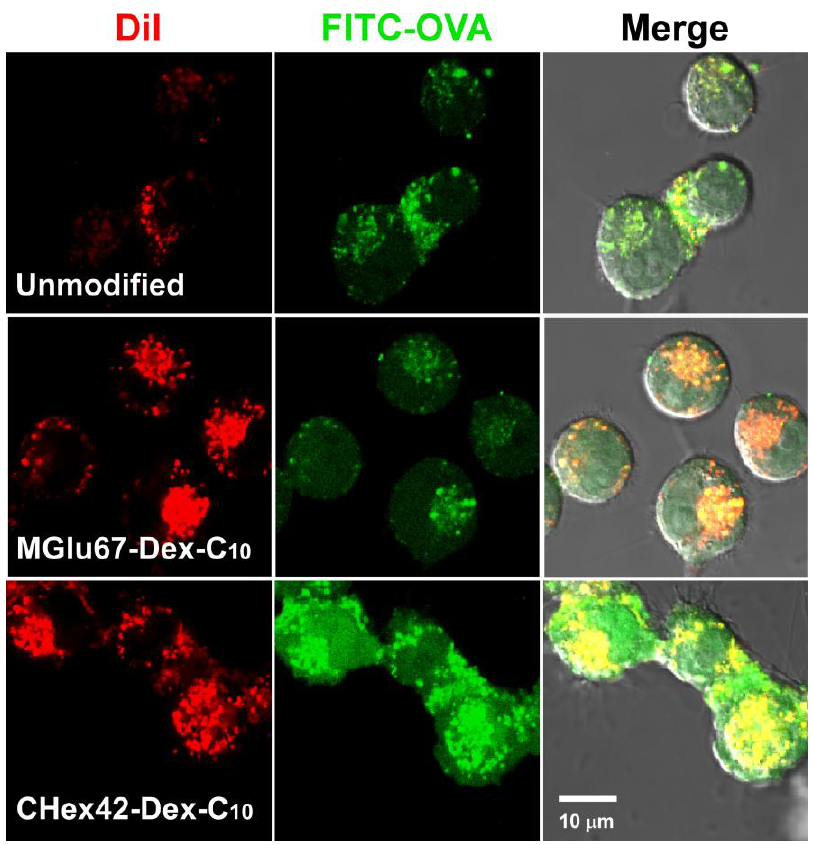
Figure 8. Confocal laser scanning microscopic (CLSM) images of DC2.4 cells treated with DiI-labeled and FITC-OVA-loaded EYPC liposomes modified with or without 30 wt % MGlu67-Dex-C 10 or 10 wt % CHex42-Dex-C 10 for 4 h at 37 °C in serum-free medium. Scale bar represents 10 μm. DiI-fluorescence intensity for liposome modified with CHex42-Dex-C 10 was decreased to distinguish the distribution of liposomes. Lipid concentration was 5.0 × 10 −4 M .